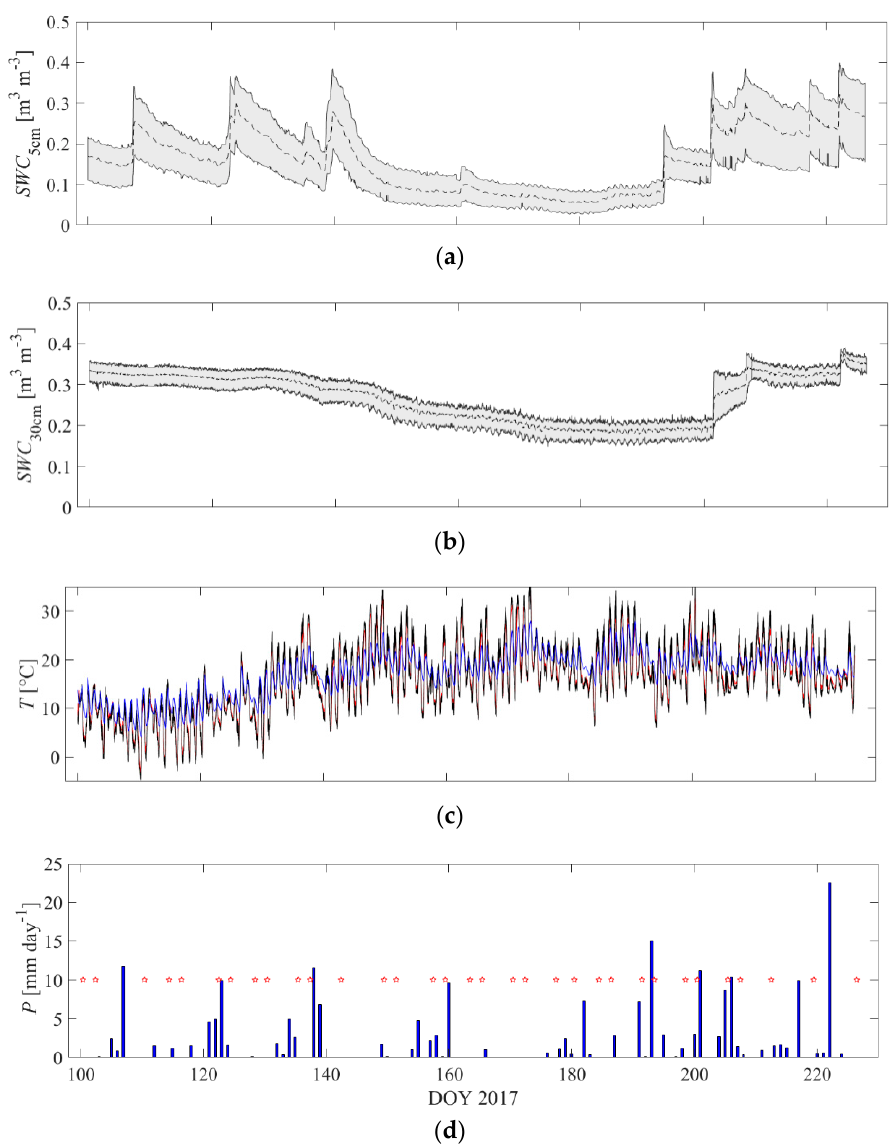
Figure 3. Volumetric soil water content ( SWC ) measured at 5 cm (5TM/TE sensors) ( a ) and 30 cm (TDR sensors) ( b ) depth with mean (black dashed line) and 75% quintile (grey shaded area). Mean soil temperature ( T S ) at 5 cm depth (blue line) (5TM/TE sensors), vegetation temperature ( T C ) at 15 cm height above ground (black line) (Pt100 sensors), and air temperature ( T A ) at 2 m height above ground (red line) taken from the TERENO Selhausen climate station ( c ). Daily precipitation ( P ) taken from TERENO Selhausen climate station ( d ). Red stars in ( d ) indicate the radiometer measurement days.